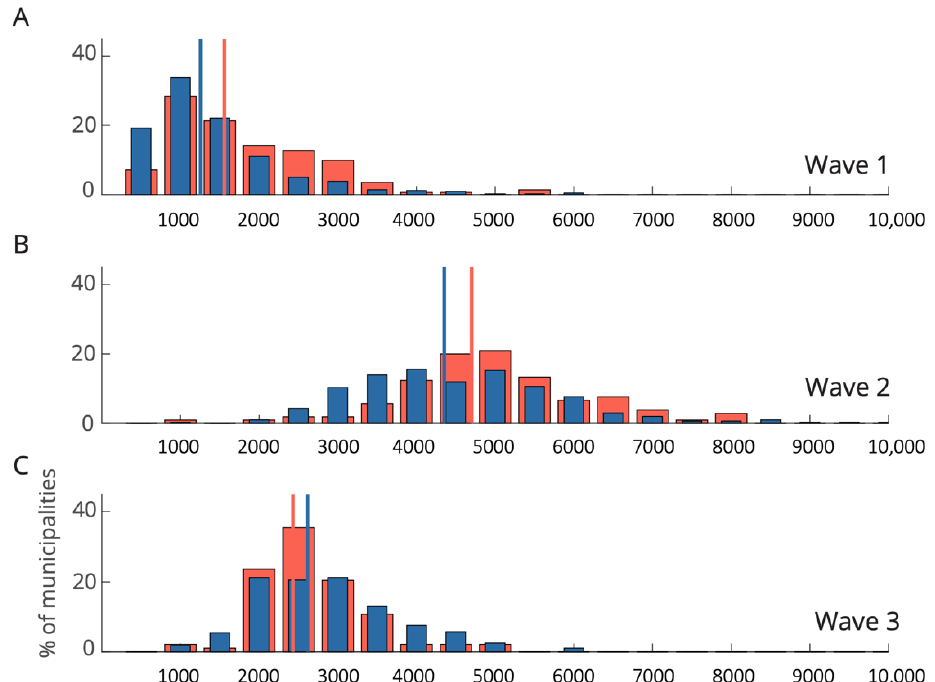
24 of 27 Figure A2. Distribution of COVID-19 Cumulative Infection Rates (per 100k) by New Jersey munic- ipalities characterized as Relatively High Percentages of Latinx Residents (RHL-red) and Relatively